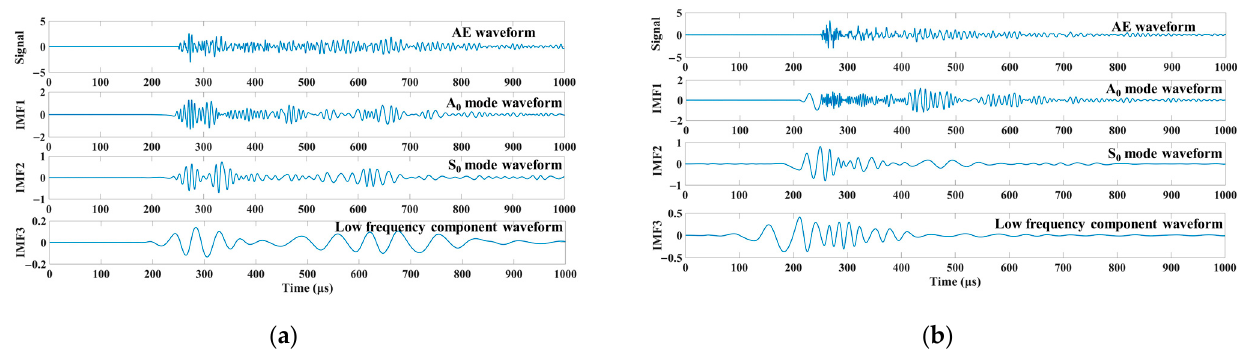
Figure 7. Signal modal component waveform diagram: IP source ( a ), OP source ( b ).